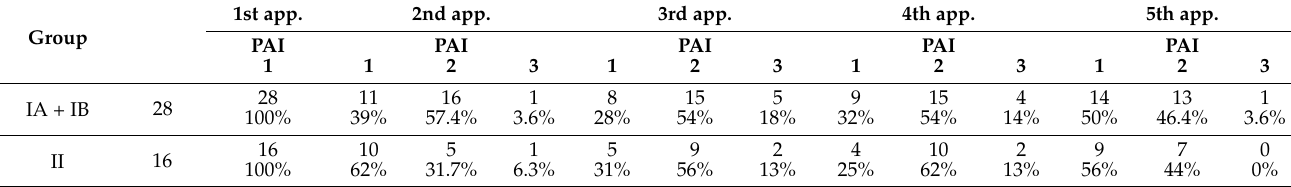
Table 5. The recorded scores of PAI index during each